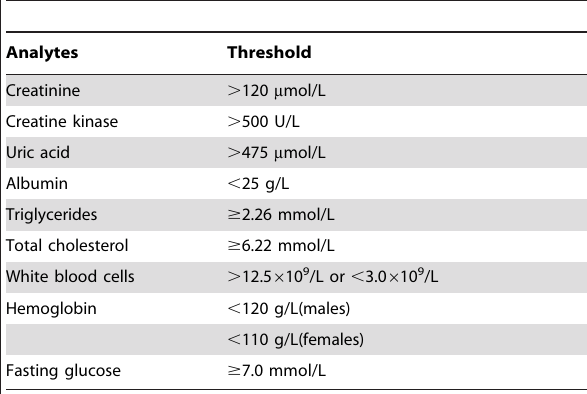
Table 1. Analytes and the corresponding thresholds for exclusion of